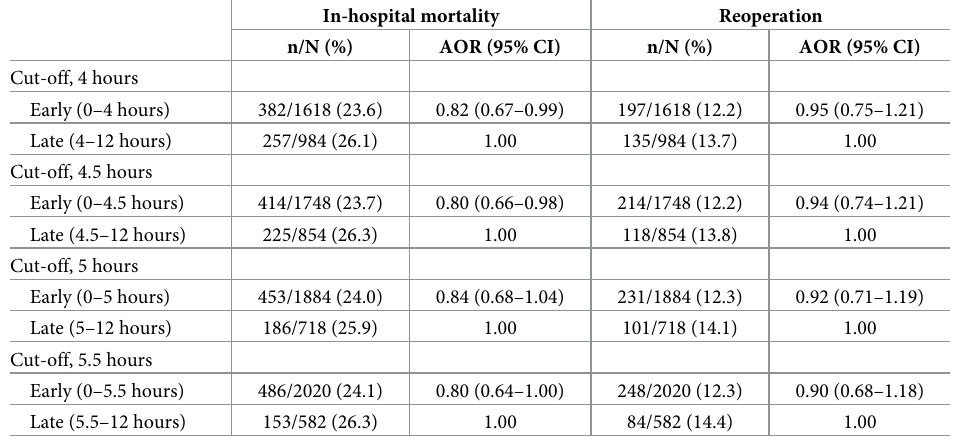
Table 5. Sensitivity analysis for cutoffs of time from emergency department visit to emergency